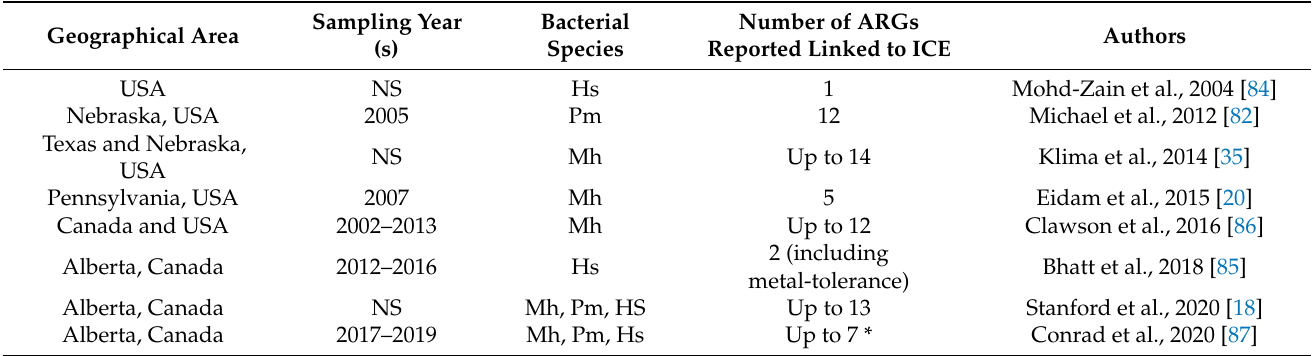
Table 3. Summary of the North American studies that detected integrative and conjugative elements in bovine respiratory disease bacteria isolated from feedlot